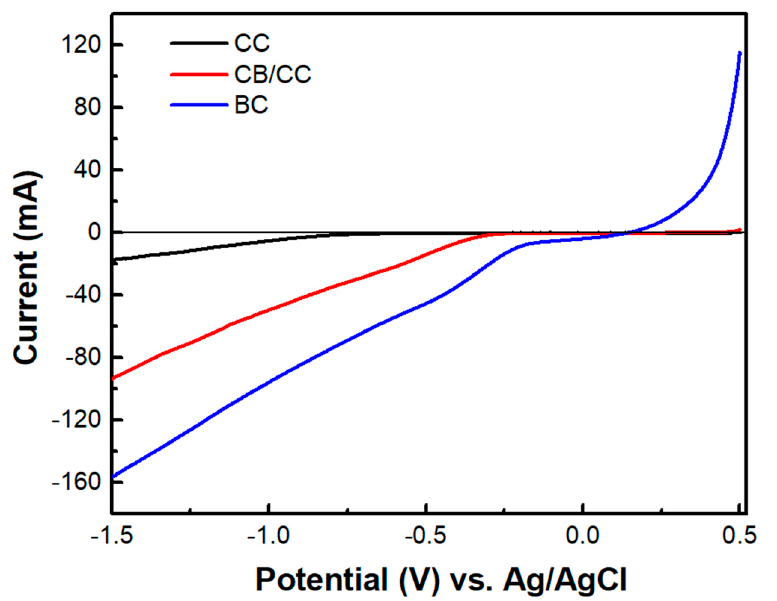
Figure 10. Linear sweep voltammetry curves were recorded with three different samples as working electrodes: CC carbon cloth, CB/CC carbon black on carbon cloth, and BC biochar on carbon